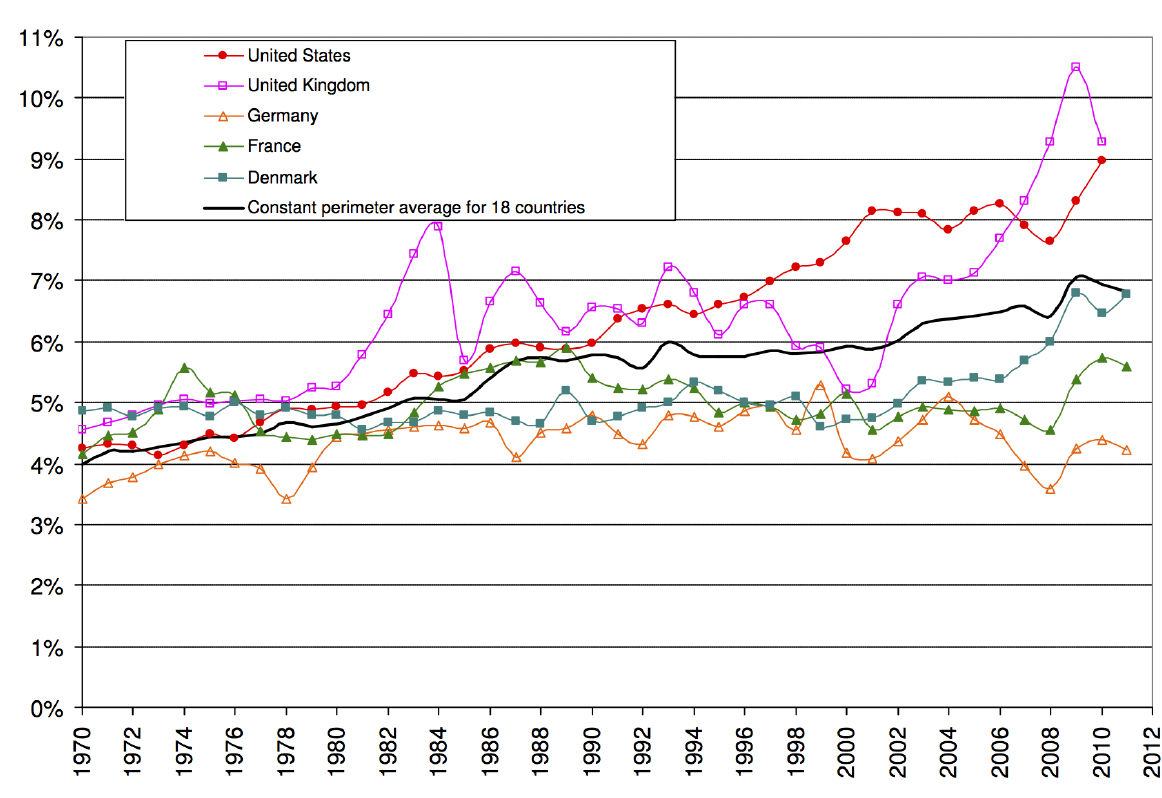
Figure 2: Evolution of the GDP share of finance